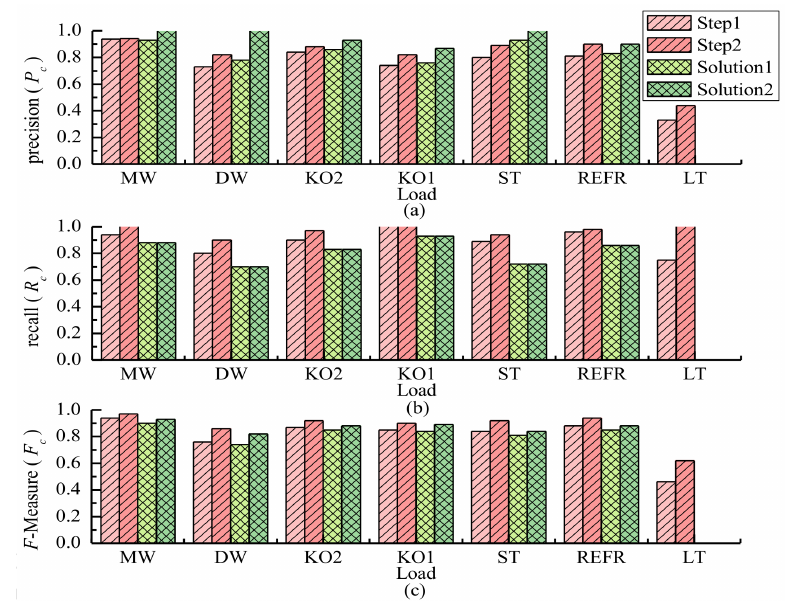
Figure 4. Classification performance comparison of two GSP-based approaches for House